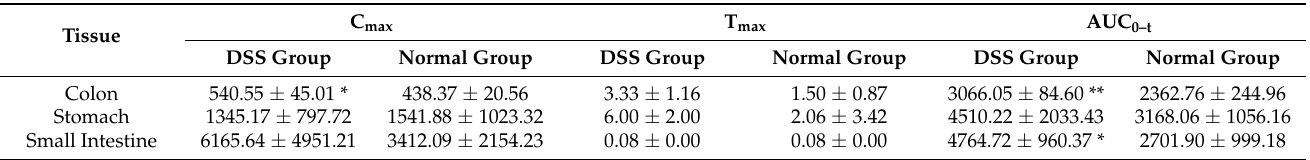
Table 4. Pharmacokinetic parameters of myricetin in DSS-group mice and normal-group mice after